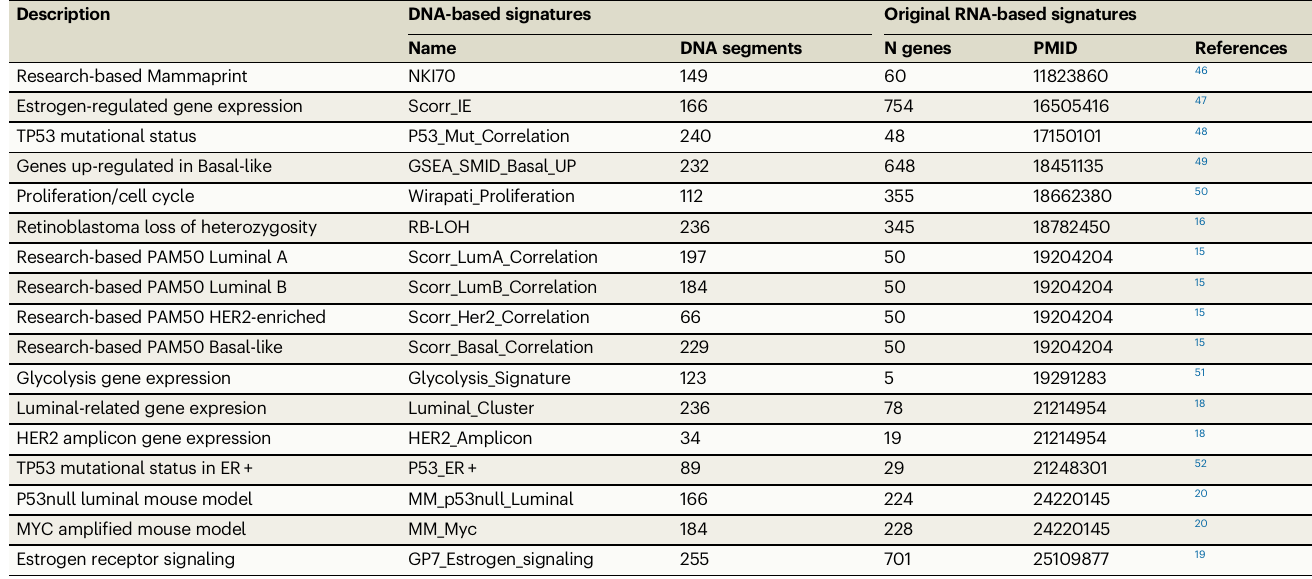
Table 1 | Description of selected DNA-based signatures